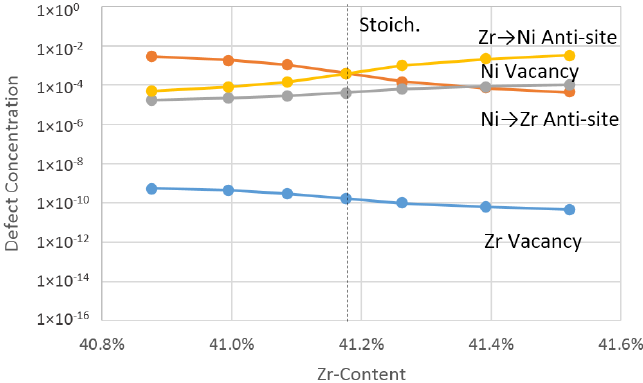
Figure 3. Theoretical defect concentrations for Zr 7 Ni 10 at 1000 °C.